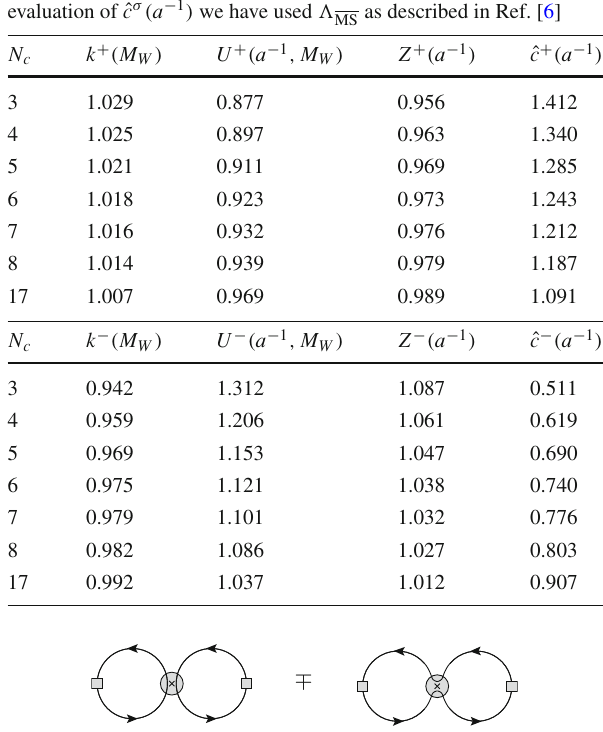
Fig. 1 Left diagram: O suud ( x ) insertion or colour-disconnected con- tributionto C ± inEq.(10).Rightdiagram: O sduu ( x ) insertionorcolour- 3 connected contribution to C ± in Eq. (10) 3